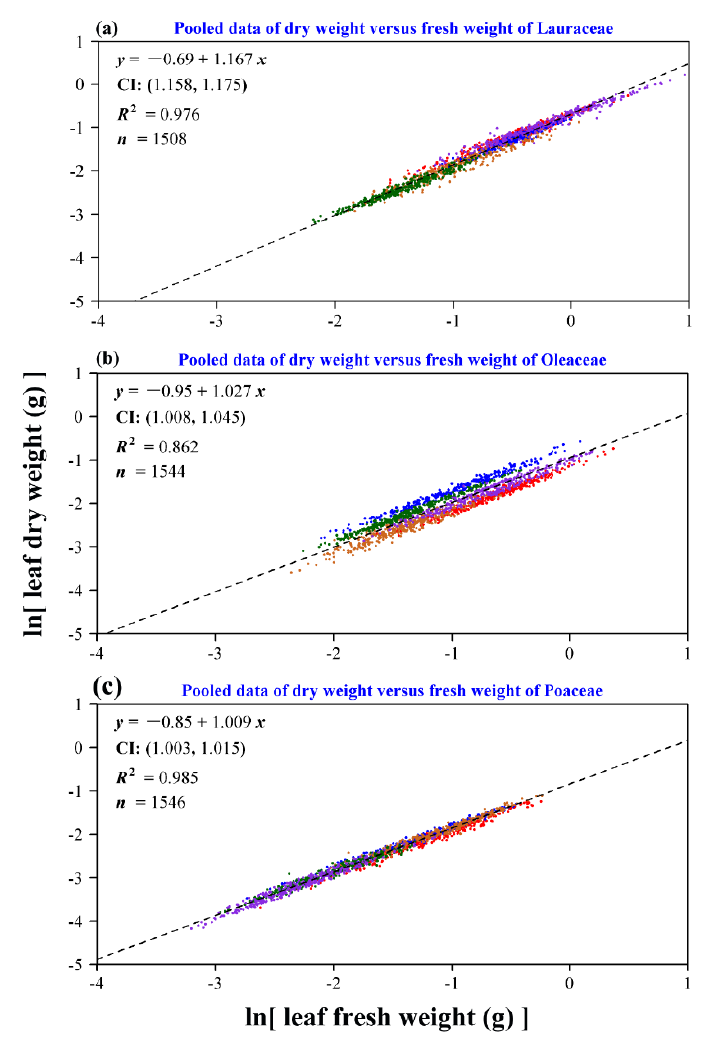
Figure 3. Scaling relationship of leaf dry weight to fresh weight for the pooled data of every family: ( a ) Lauraceae; ( b ) Oleaceae; ( c ) Poaceae. In each panel, the colored points represent the observations, and the black dashed line represents the reduced major axis regression line. Furthermore, y represents the natural logarithm of leaf dry weight in g, x represents the natural logarithm of leaf fresh weight in g, CI represents the 95% confidence interval of the slope, R 2 is the coefficient of determination used to measure the goodness of fit, and n represents the total number of the sampled leaves for the five species of the same family. Different colored points represent different species in each panel, but points having the same color in different panels do not represent the same species.